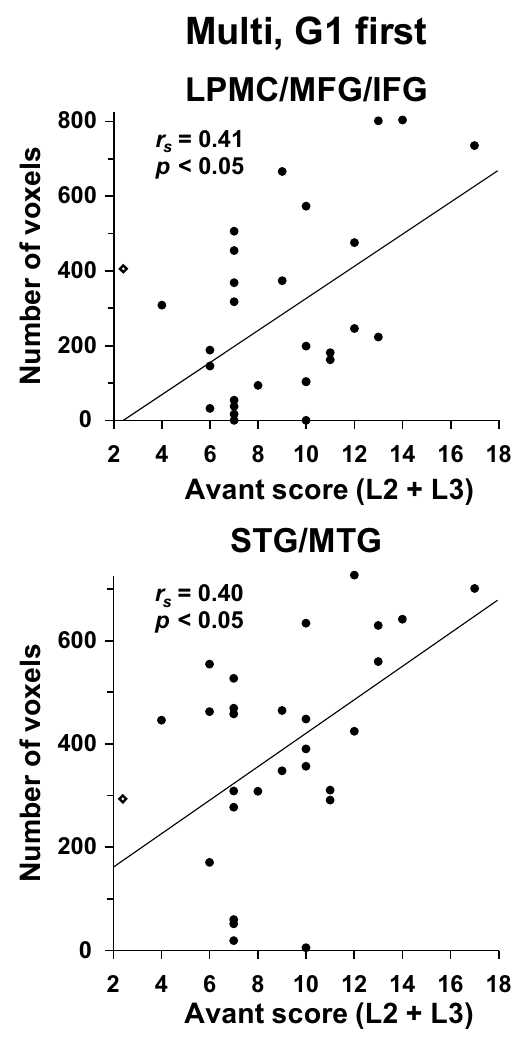
Figure 7. Activations for G1 first predicted by language proficiency of the Multi group. The numbers of voxels in the LPMC/MFG/IFG ( a ) and STG/MTG ( b ), averaged for the ROI in both hemispheres of each participant of the Multi group showed a significant correlation with the combined Avant scores. The rhombus symbols on the ordinate denote 10% voxels within each ROI, as shown in Fig. 6. These images were created using Microsoft Excel 2013 and Adobe Illustrator (as